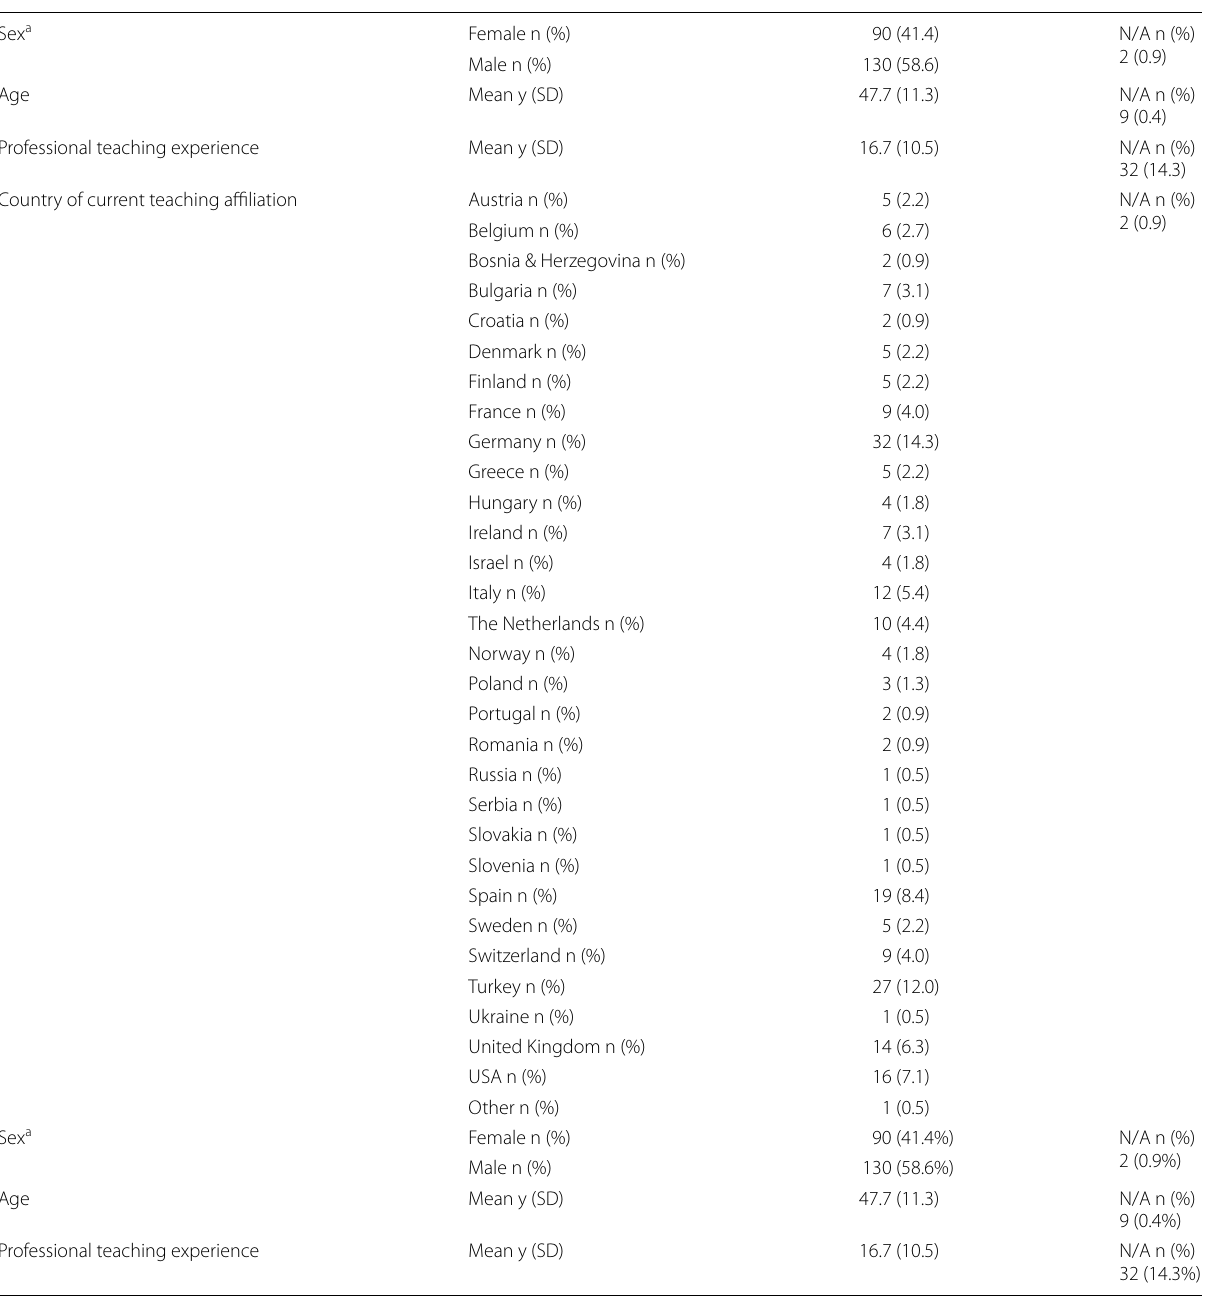
Table 1 Demographic characteristics of the